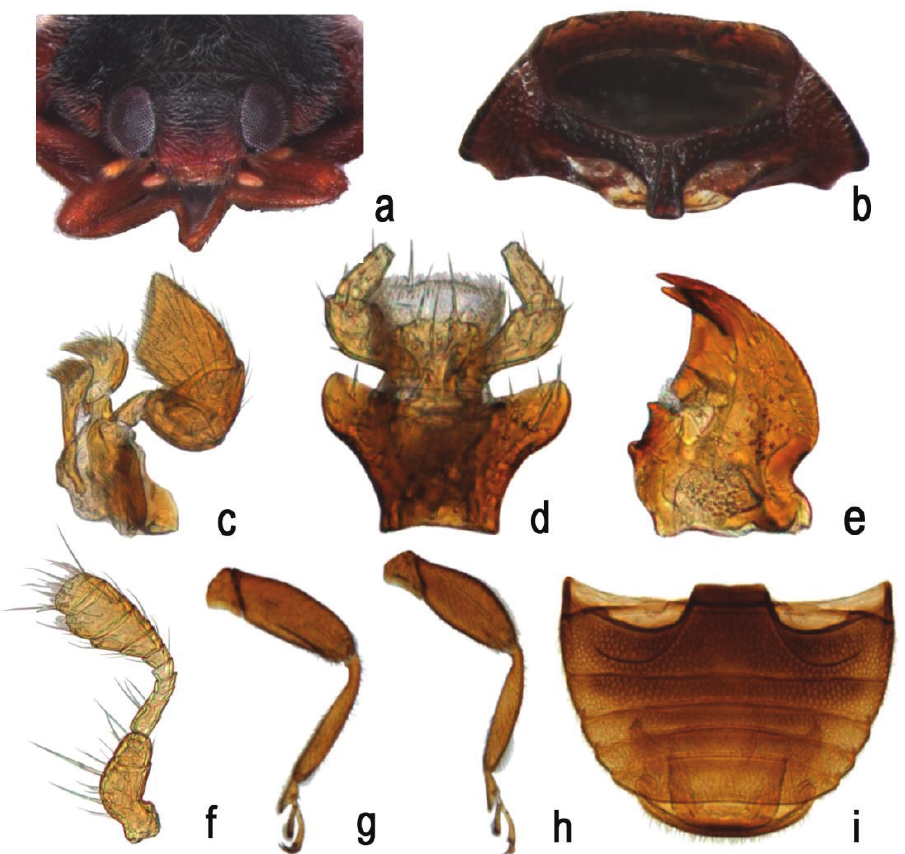
Figure 1. Scymnus ( Scymnus ) contortubus Rashid, Chen & Wang, sp. n.: a head, frontal b prothorax, antero-ventral c maxilla d labium e mandible f antenna g fore leg h hind leg i abdomen, male.